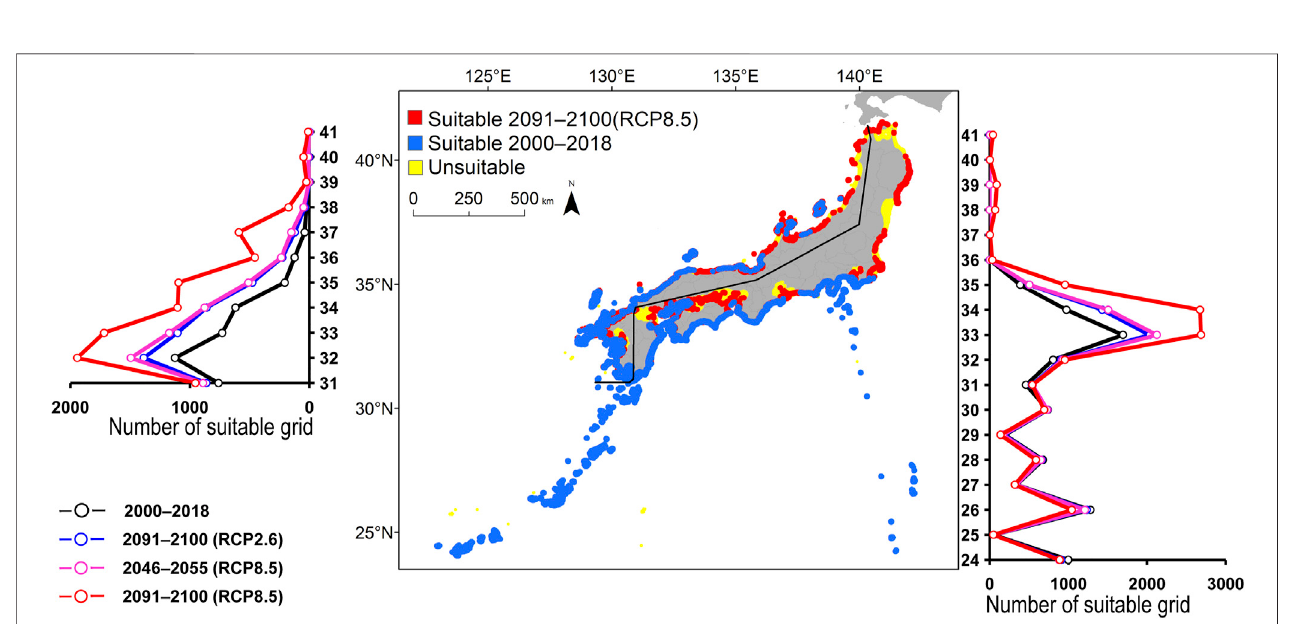
FIGURE 4 | Estimated distribution of Kyphosus bigibbus . See Figure 2 for the explanation.